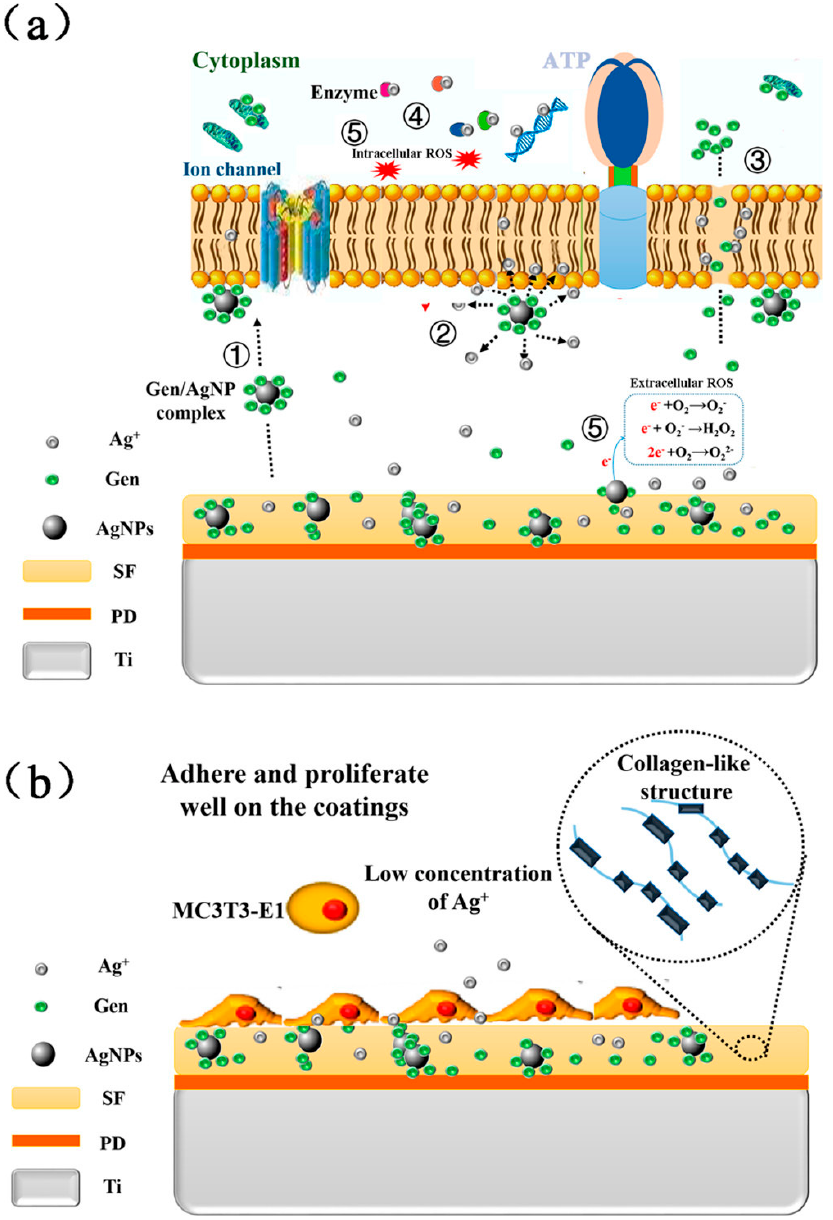
Figure 3. Schematic illustration of the possible antibacterial ( a ) and biocompatible ( b ) mechanism on the AgNPs/Gen-contained SF-based coatings. Reprinted with permission from [31]. Copyright 2017 American Chemical Society.